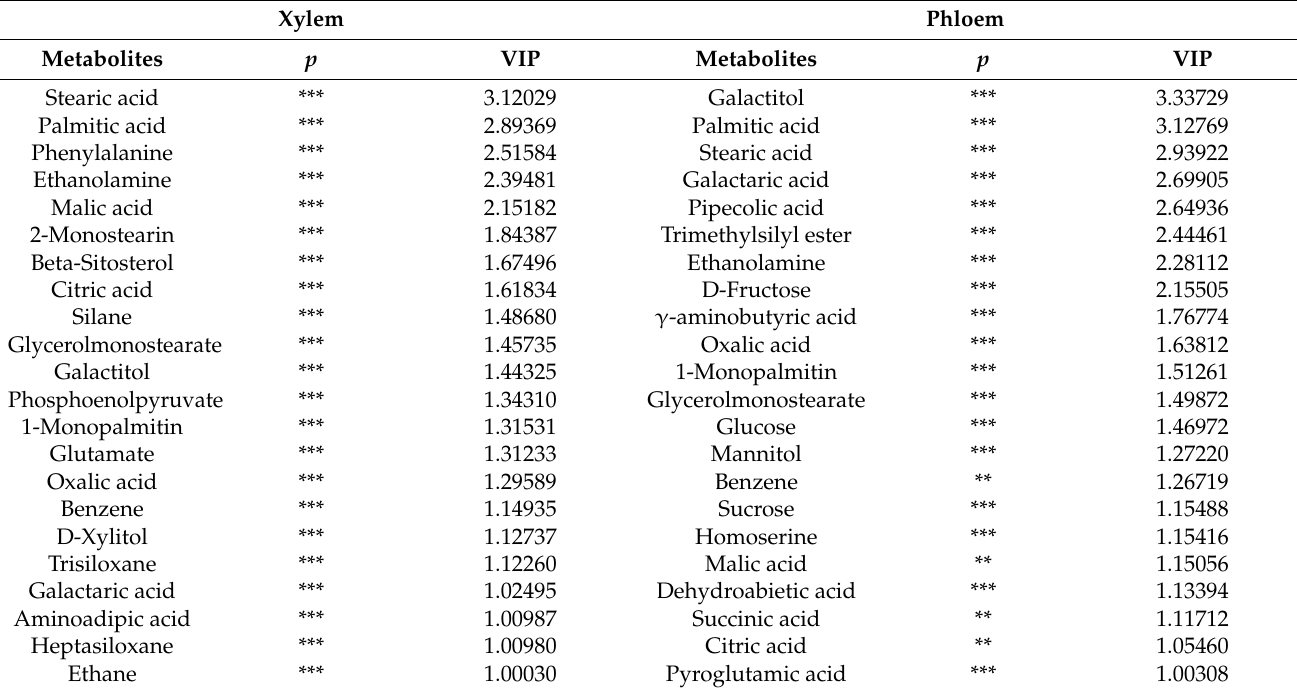
Table 1. The differential metabolites in xylem and phloem sap of Cucumber under different phospho- rus stress analyzed by PLS-DA